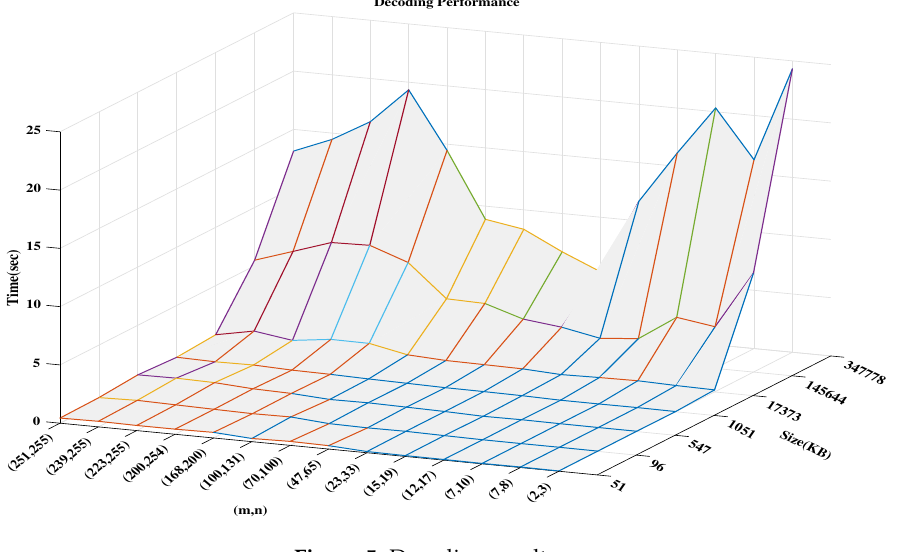
Figure 5. Decoding